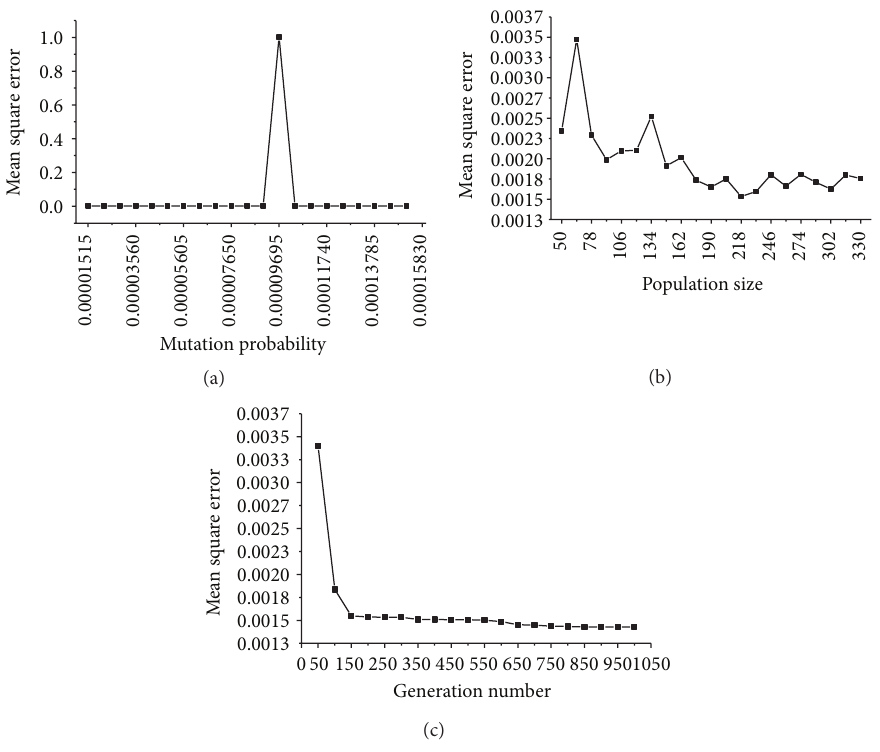
Figure 4: GA-NN parametric study. (a) Mutation probability, (b) population size, and (c) generation number.